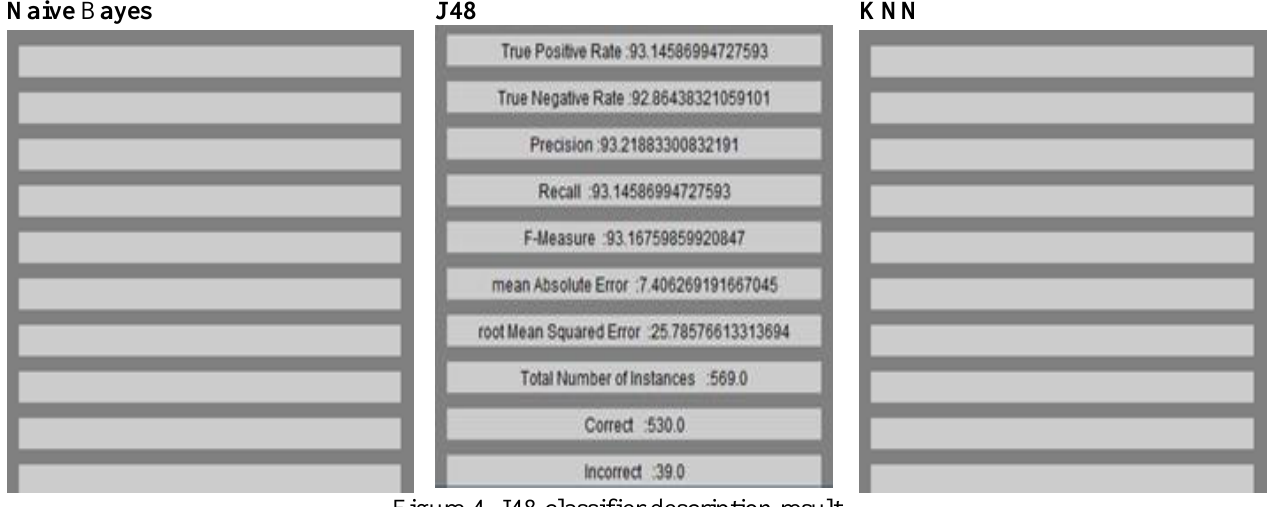
Figure 4. J48 classifier description result Table 2. Detailed Accuracy by Class for